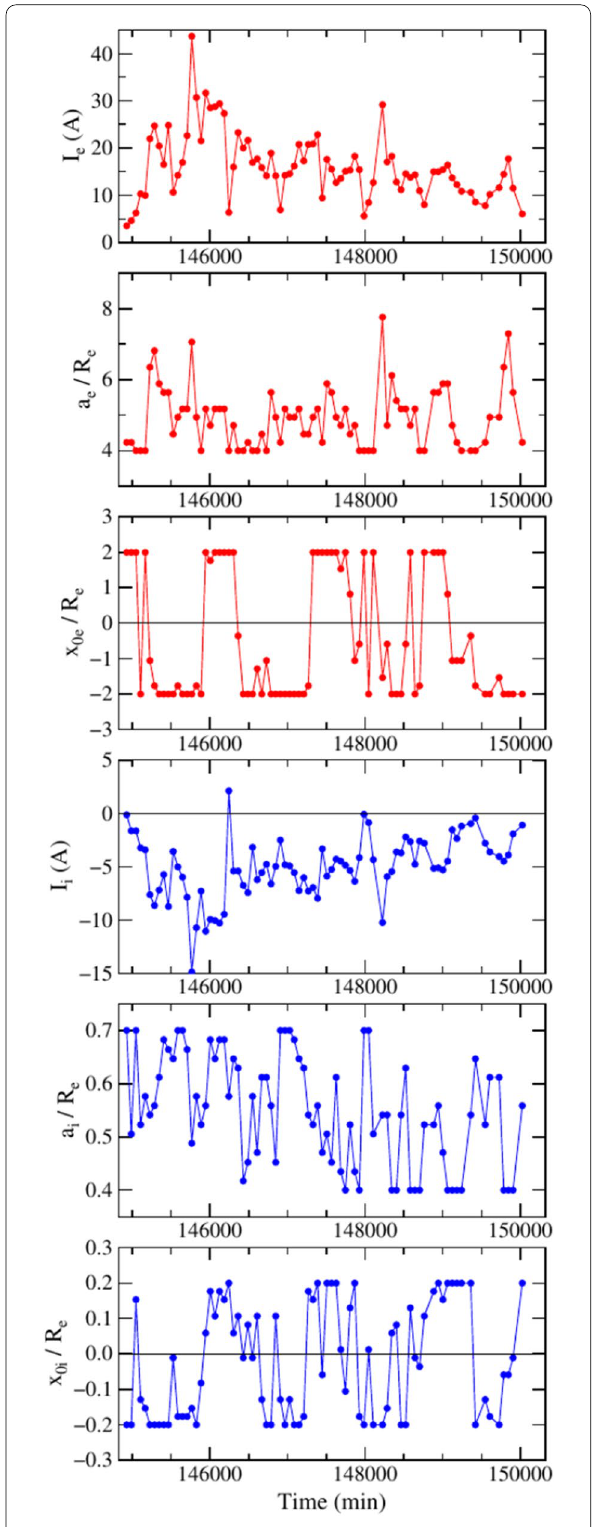
Fig. 13 The time evolution of external parameters I e , a e and x 0 e (red) and internal parameters I i , a i and x 0 i (blue) of model MMC best-fitting residuals � X ( 2 ) sm , � Y ( 2 ) sm and � Z ( 2 ) in each time bin. Time span covers the magnetic storm analysed in Fig. 1